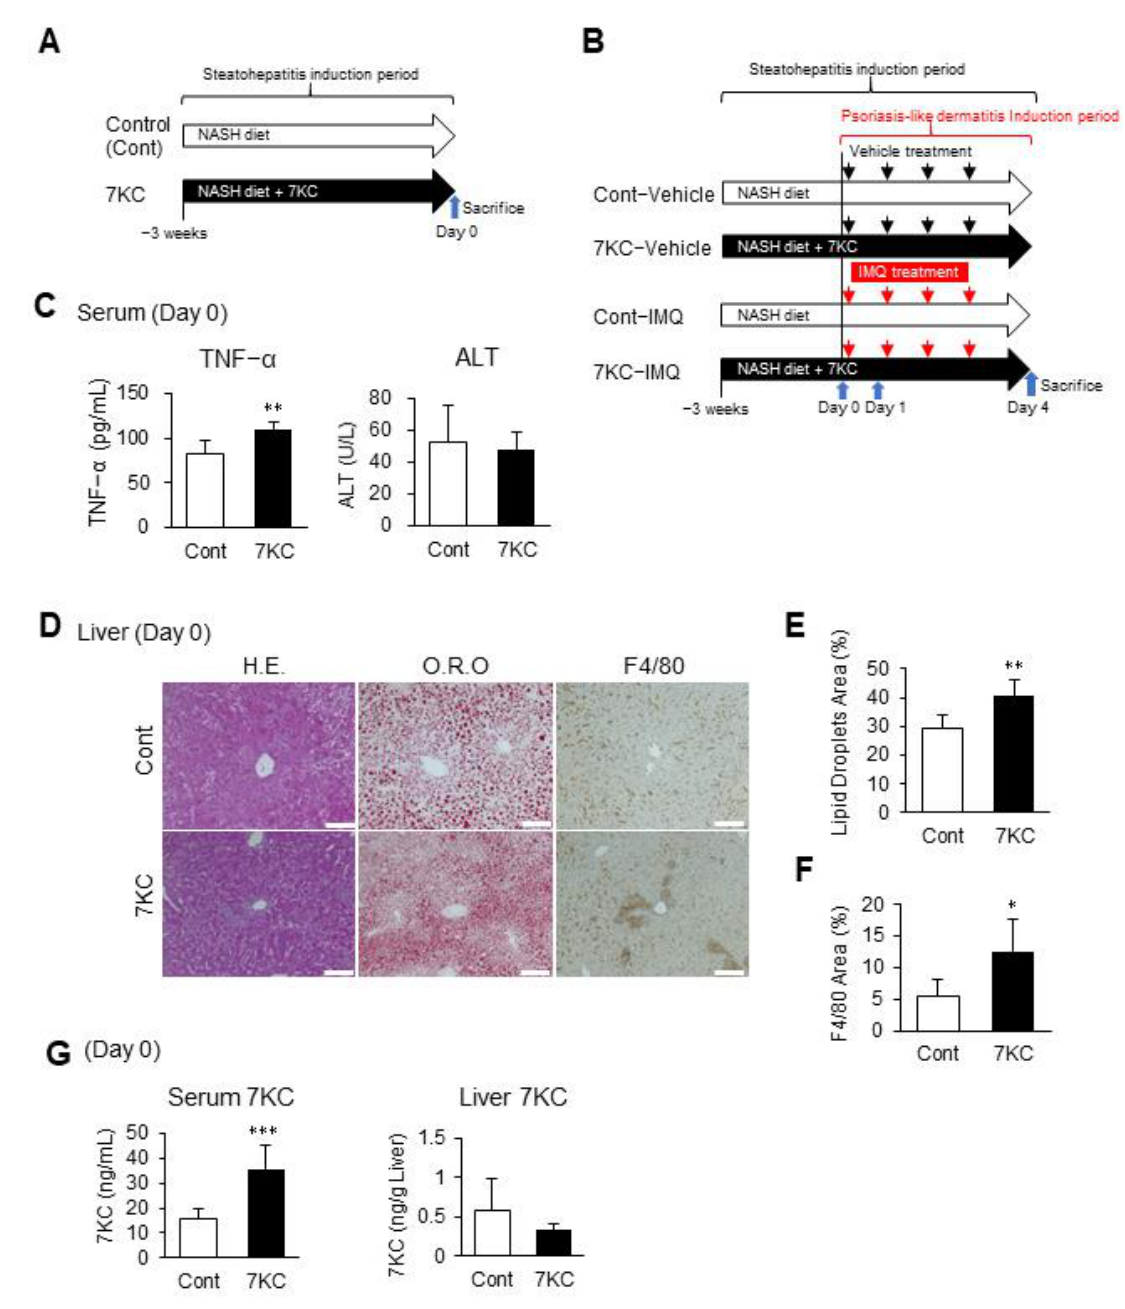
Figure 1. The 7KC-containing high-fat/high-cholesterol/high-sucrose/bile salt diet exacerbated steatohepatitis in C57BL/6 mice. ( A ) Experimental protocol before induction of psoriasis-like dermatitis. Samples were harvested on Day 0. ( B ) Experimental protocol after induction of psoriasis-like dermatitis. Samples were harvested on Day 1 and Day 4. ( C ) TNF- α and alanine aminotransferase (ALT) in serum on Day 0. n = 6, Control; n = 6, 7KC. ( D ) Hematoxylin and eosin (H.E.) staining, oil red O (O.R.O) staining, and F4/80 staining of liver samples on Day 0. Scale bar: 100 μm. ( E ) Areas with oil red O staining in the liver. n = 6, Control; n = 6, 7KC. ( F ) Areas with F4/80 staining in the liver. n = 6, Control; n = 6, 7KC. ( G ) 7KC concentrations in serum and liver of mice on Day 0. n = 5, Control; n = 5, 7KC. Results are presented as mean ± SD, and p values were calculated using Student’s t -test. * p < 0.05, ** p < 0.01, and *** p < 0.001, Control vs. 7KC.